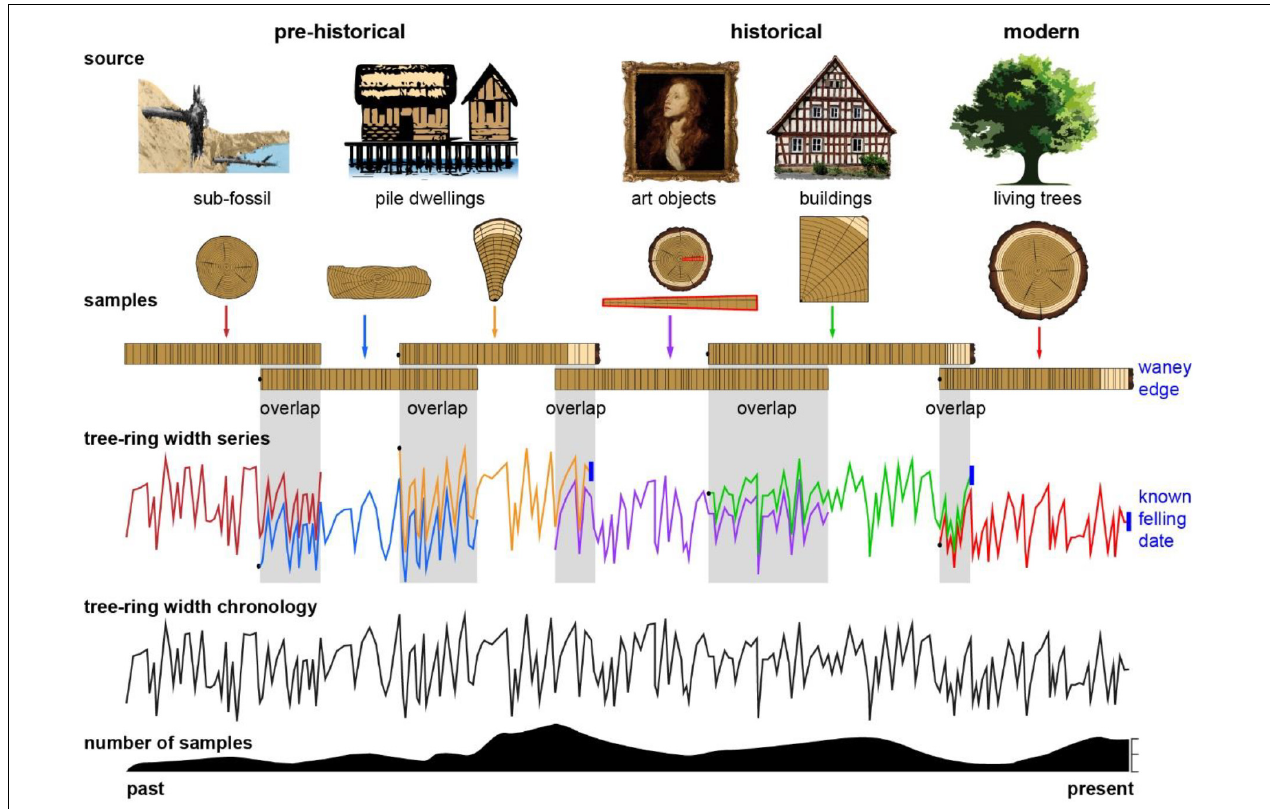
FIGURE 2 | Schematic illustration of the crossdating process. The climatic-related sequences of wide and narrow rings of the wooden samples allow the dating of wood from different sources and the development of millennia-long tree-ring width chronologies. Since the material is not evenly available through time, consequently the number of samples (replication) varies